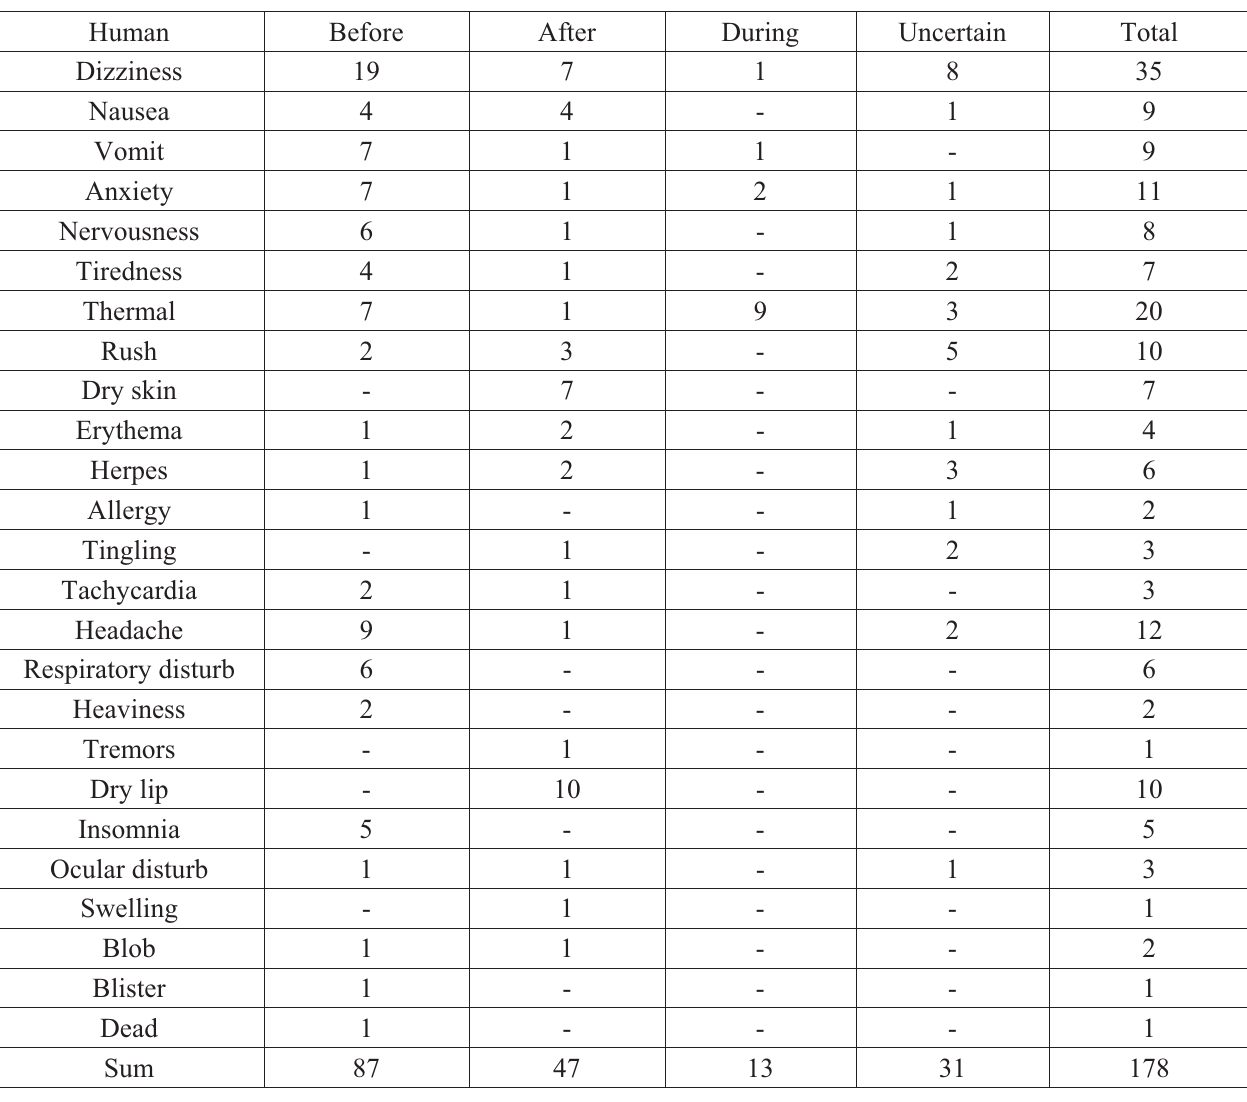
Table 4. Human summary.